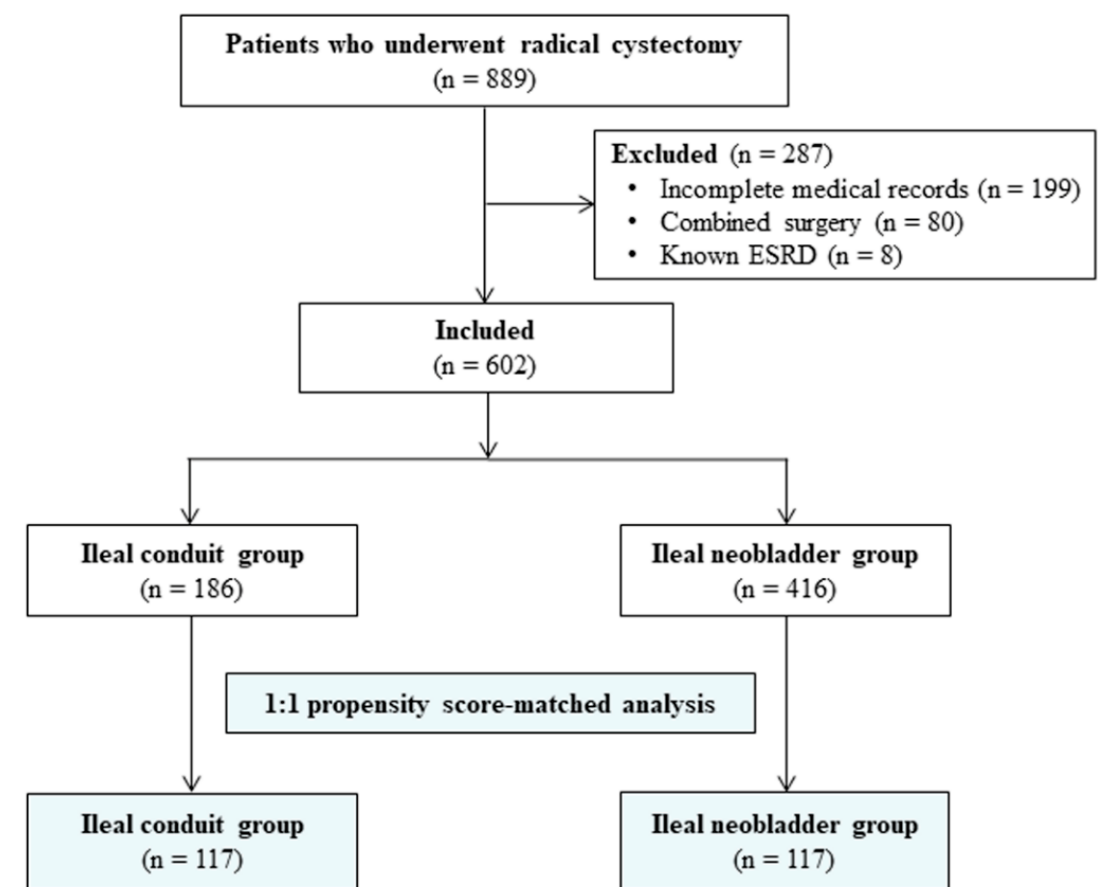
Figure 1. Flowchart of the study’s patients: 889 patients who underwent radical cystectomy were evaluated, and 602 patients were included in the study. Patients were dichotomized according to urinary diversion type, and a propensity score-matched analysis was performed.